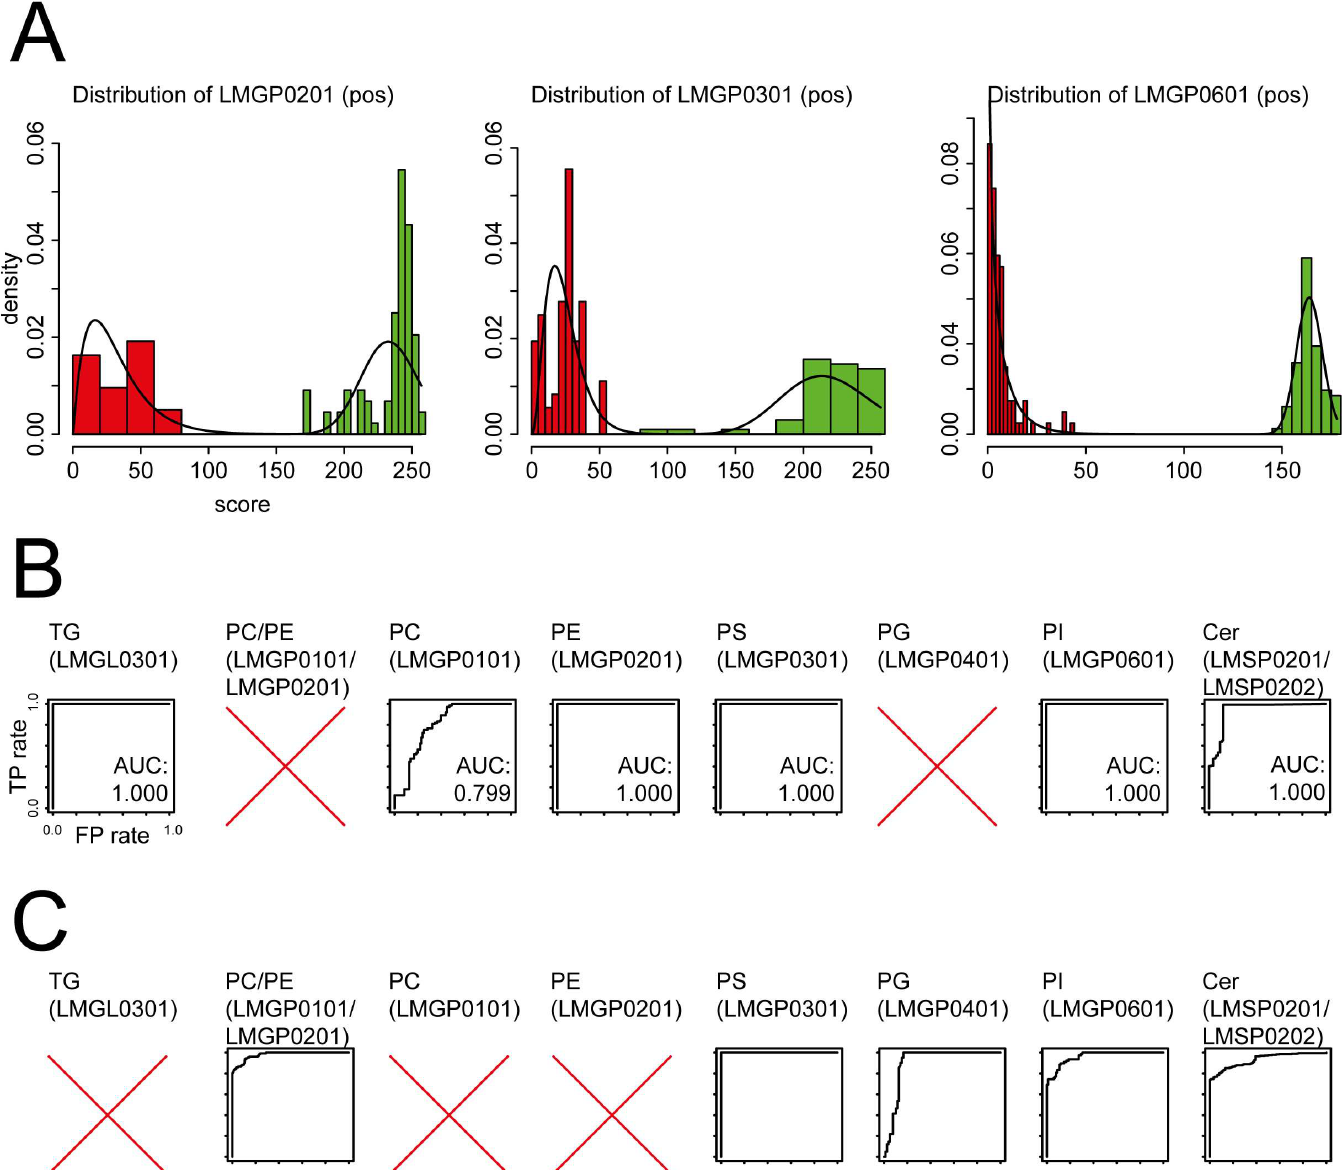
Fig 2. Visualization of input data and results obtained by LipidFrag. (A) Examples of histograms showingdistributionof raw MetFrag score for the back- and foregroundtrainingdataset. (B) Receiver-Operator characteristics (ROC) derived from 10-fold cross-validation of MS/MS spectra from lipid standard materials detected negativeion mode. (C) Receiver-Operator characteristics (ROC) derived from 10-fold cross-validation of MS/MS spectra from lipid standard materialsdetected positive ion mode. In both panels, plots having no AUC value indicate that this lipid class was not detected in this ion mode concludingthat there was not trainingdata for classifiers available. All axes have the same